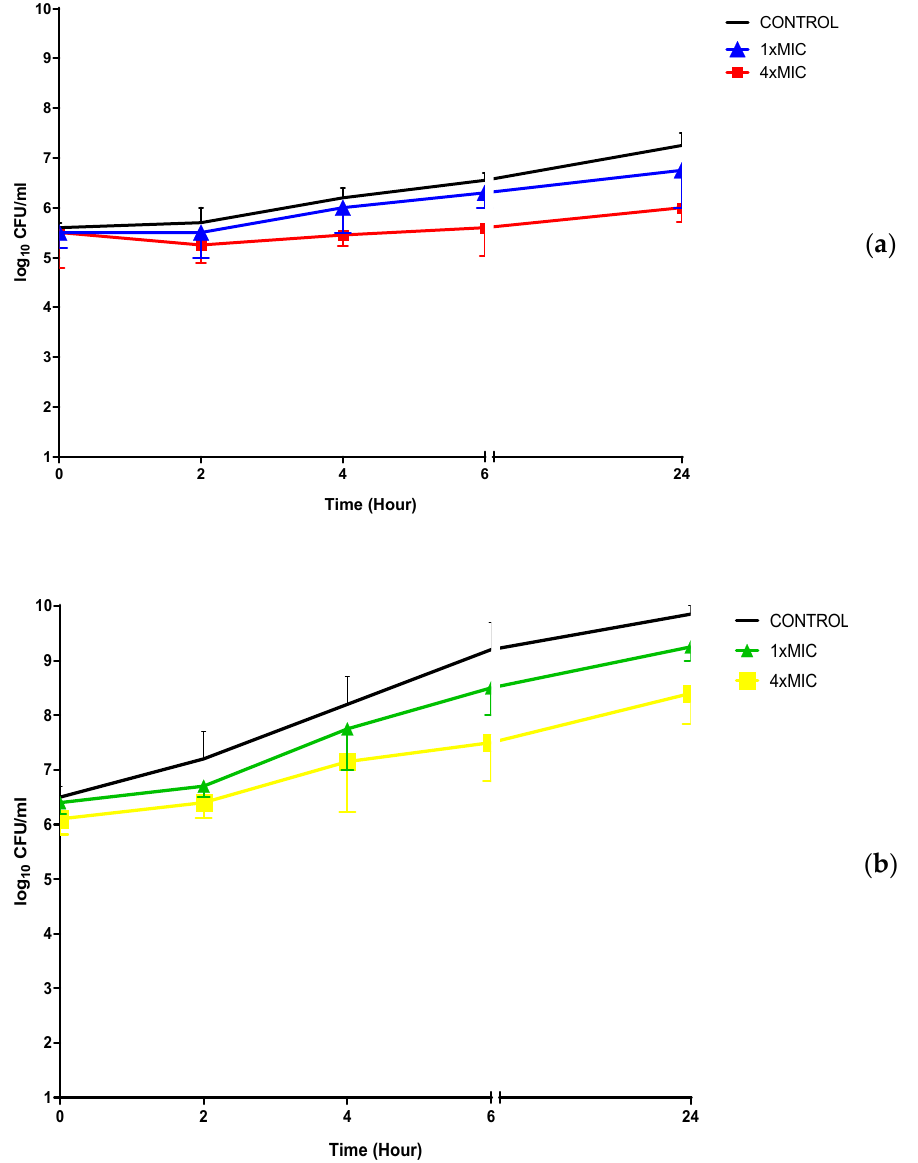
Figure 6. Time-kill determinations for clinically resistant ( a ) C. albicans and ( b ) MRSA isolates after treatment with AQQ4 and AQQ9 at 1 × and 4 × MIC, respectively. The x -axis represents the killing time, and the y -axis represents the logarithmic C. albicans and MRSA survival, respectively.